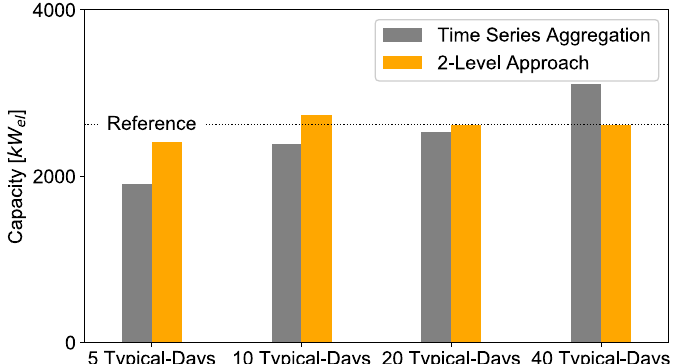
Figure 15. Deviation of installed wind energy capacities with the 2-Level Approach and time series aggregation compared to full time series.